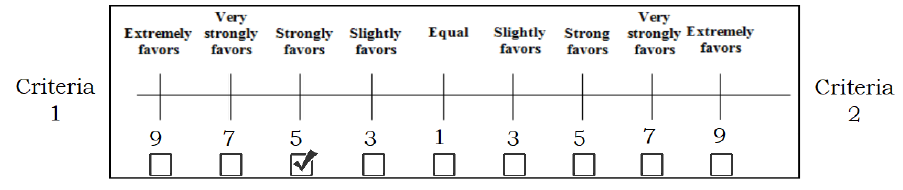
Figure 8. Sample of the questionnaire form.